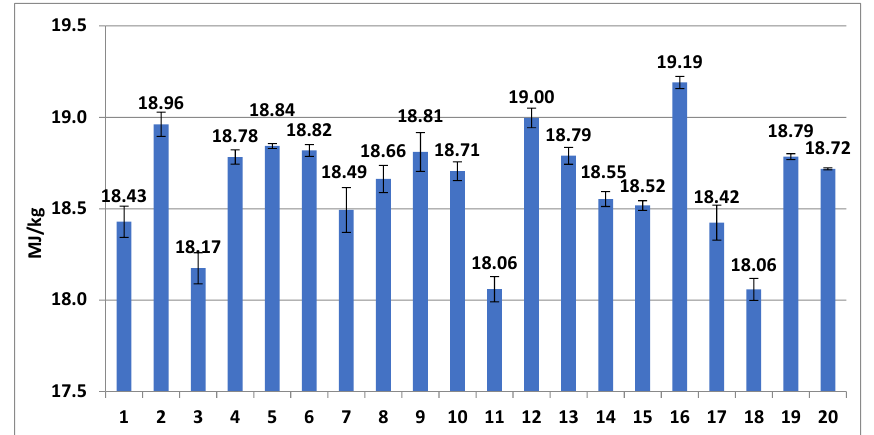
Figure 3. Mean calorific (lower heating) values (MJ/kg) of pellets.